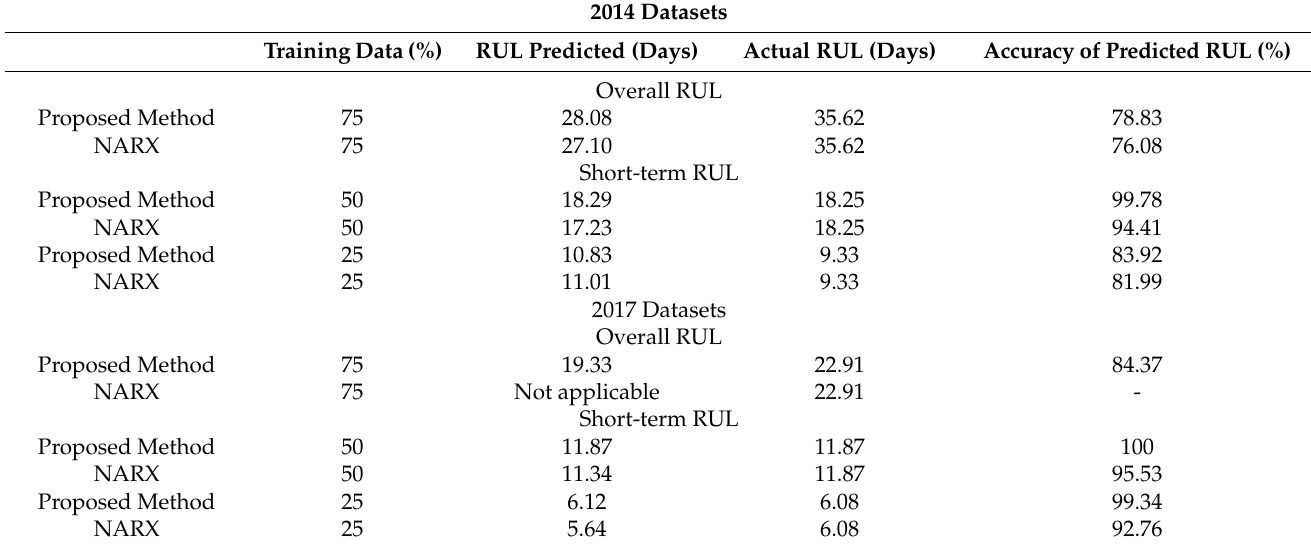
Figure 6b. Again, for predicting the short-term RUL of this slurry pump, the developed model was fed with 50 and 25% data of degradation trends for determining the RULs in the next ten operating hours., as shown in Figure 7c,d. It can be observed that the developed model’s average accuracy of the overall RUL prediction for both the slurry pumps was 81.60%, while the average accuracy for the short-term RUL prediction was 95.76%. Table 1 is showing the actual RULs, predicted RULs by the proposed model and Nonlinear Autoregressive Exogenous (NARX) model, and the accuracy of the obtained predicted RULs. Table 1. The actual RULs, predicted RULs by the NARX and the developed model, and the accuracy of the obtained predicted RULs for slurry